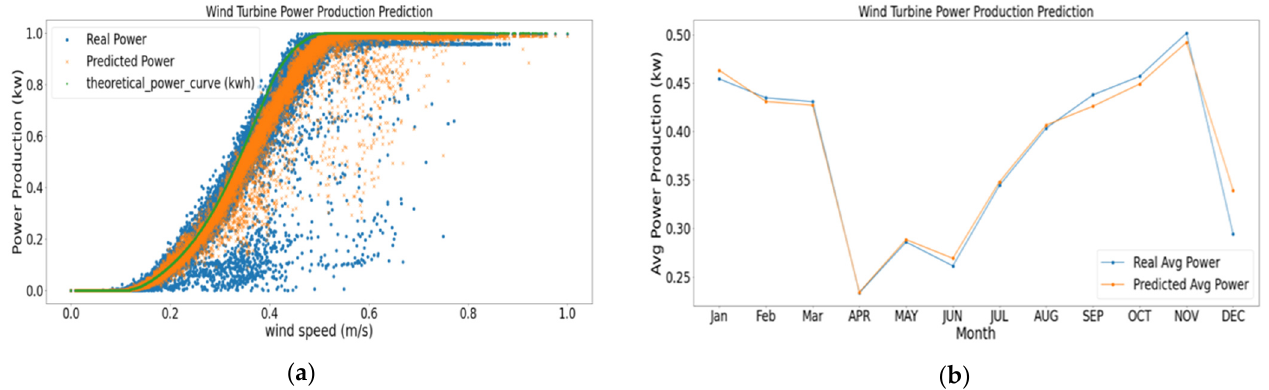
Figure 10. ( a ) Scatter plot depicting the relationship between the wind speed (m/s) and the produced power (kW) when using random forest regression. ( b ) Predicted average of wind power as compared with the real average power (kW) when using random forest regression.